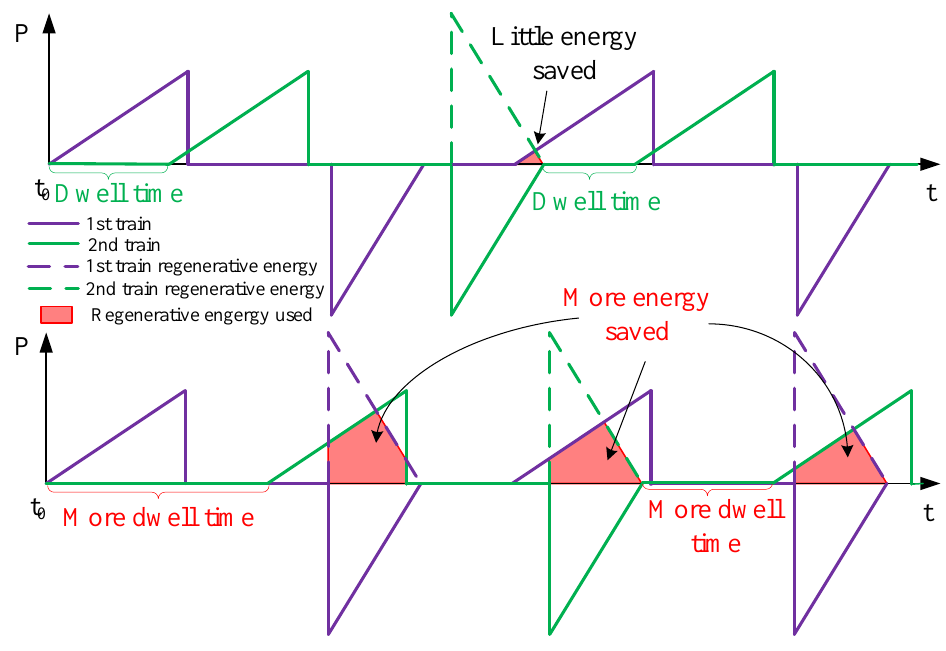
Figure 1. Change dwell time to use regenerative